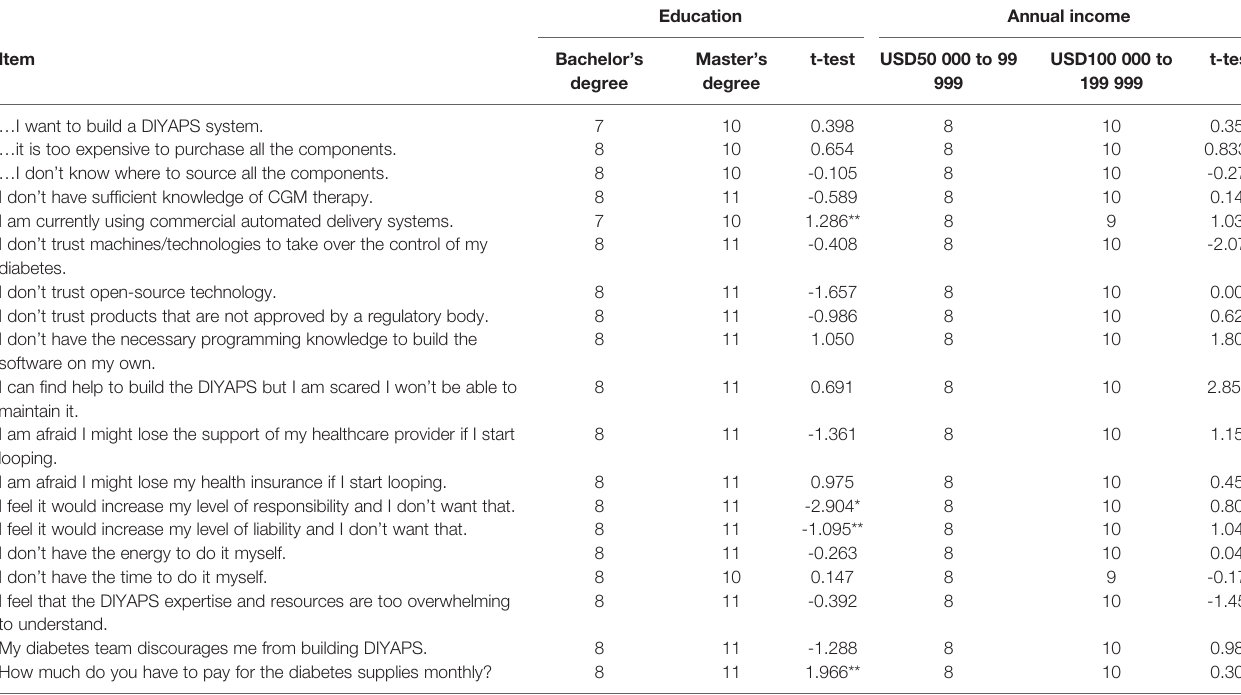
TABLE 2 | Comparison of education and annual household income level of caregivers of children and adolescents who are non-users of open-source AID. Education Annual